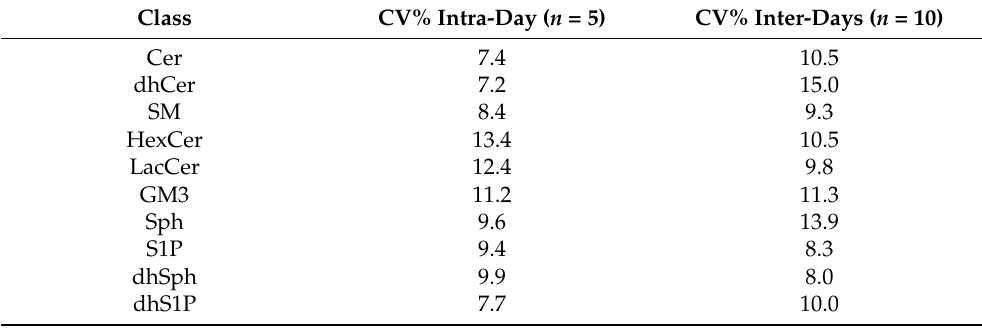
Table 2. Intra- ( n = 5 independent extraction replicates) and inter-days ( n = 10 independent extraction replicates) precision for the analysis of the whole panel of RBCs sphingolipids on an RBCs pool from healthy volunteers ( n = 20). The analyses of the sphingolipids and sphingoid bases were performed as described in Sections 3.3.1 and 3.3.2 (long chromatography), respectively.